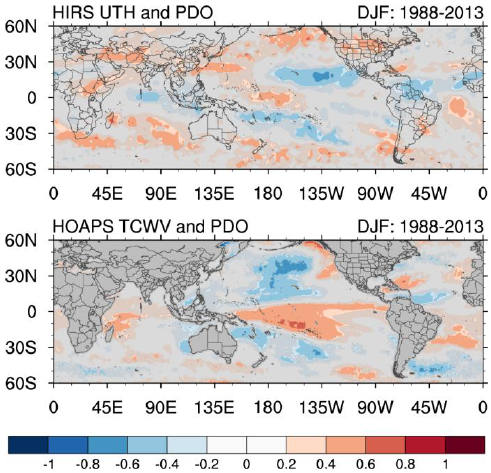
Figure 8. Similar to Figure 7 for correlations with the Pacific Decadal Oscillation (PDO) index.